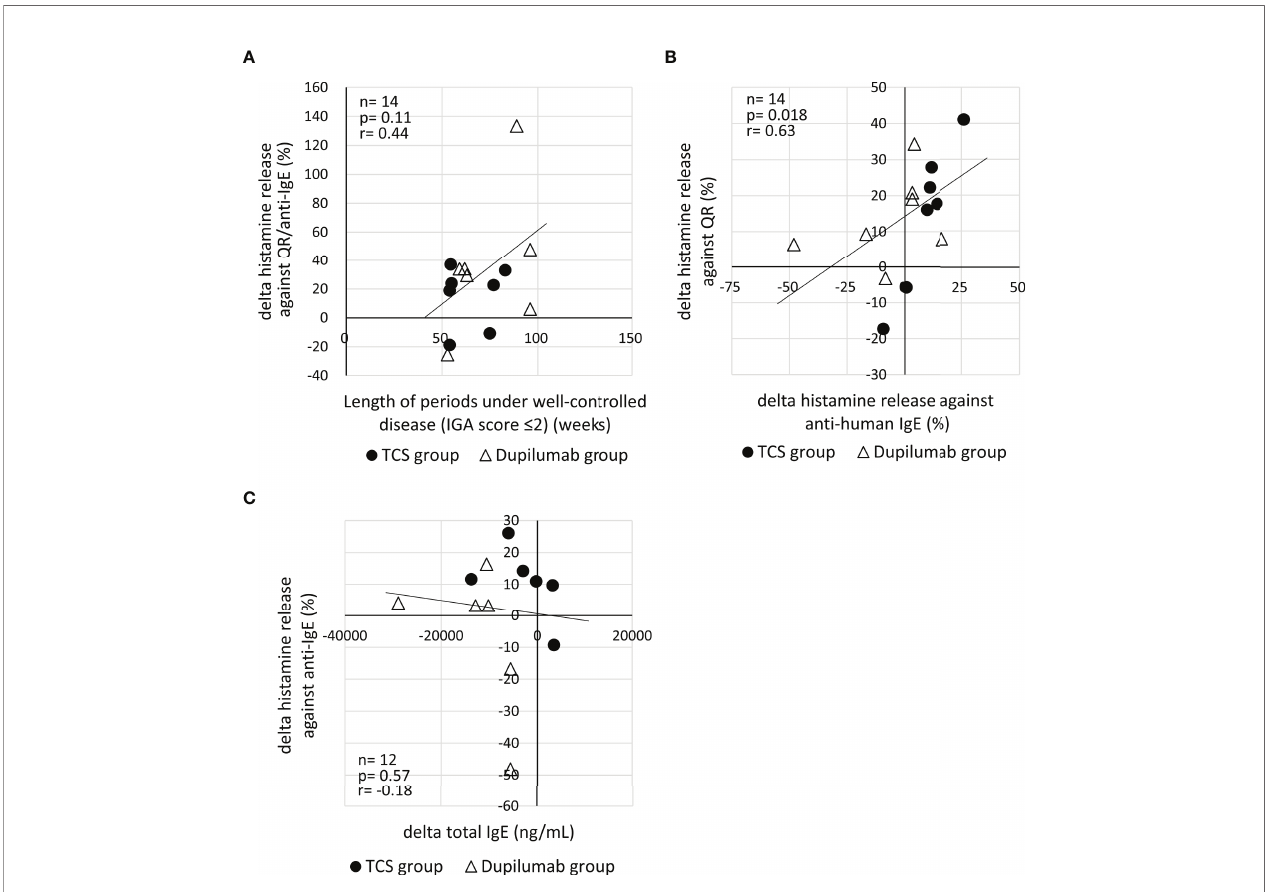
FIGURE 3 | (A) Correlation of the change of histamine release in response to QR to the length of periods under a well-controlled disease (IGA ≤ 2). Histamine release was expressed as (net % of histamine release induced by QR)/(net % of histamine release induced by anti-IgE)×100 (%). (B) Correlation between the change of histamine release in response to QR and that of histamine release in response to anti-human IgE. (C) Correlation of the change of histamine release in response to anti-human IgE with the change of serum total IgE. “ delta ” means the changes of parameters calculated by the subtraction of values at E1 from those at E2. E1, the 1st evaluation; E2, the 2nd evaluation; IGA, Investigator ’ s Global